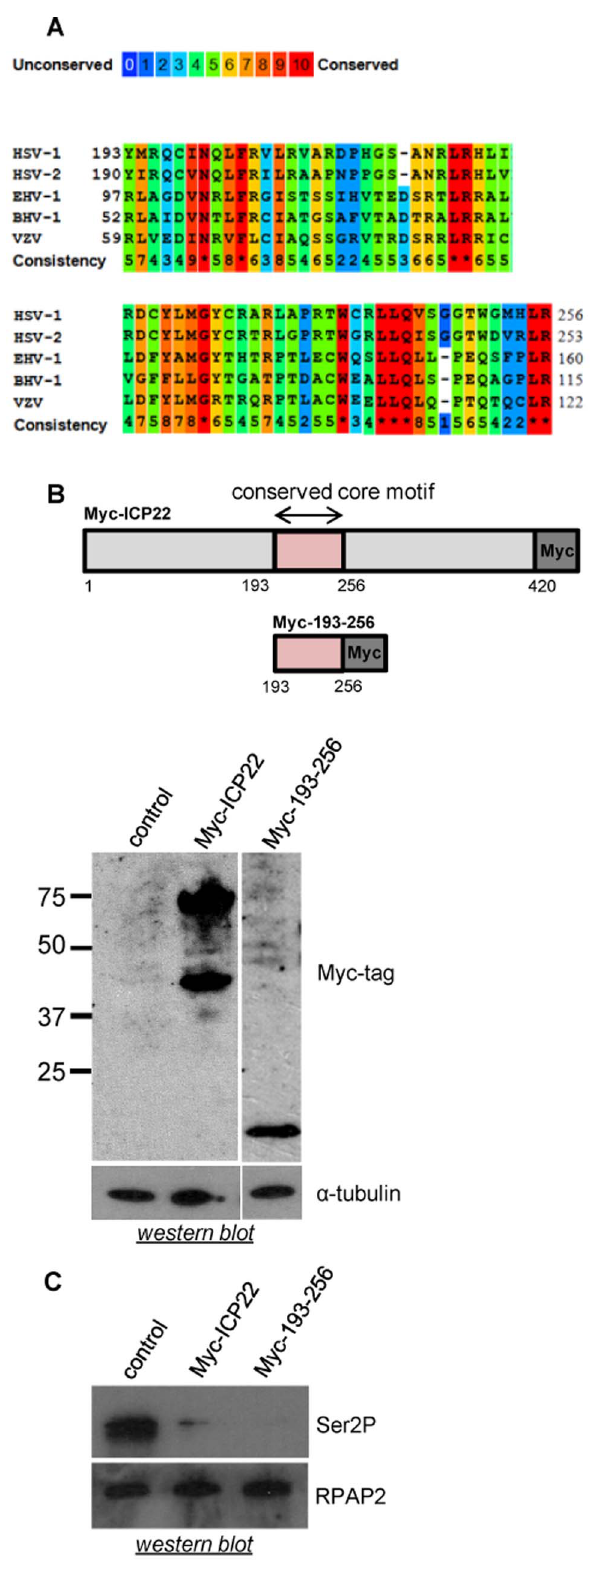
Figure 2. Ectopic expression of ICP22 or the 193–256 subdomain causes loss of pol II CTD Ser2 phosphorylation. Alignment of the conserved core motif within ICP22 of the alphaherpesviruses showing the degree of conservation according